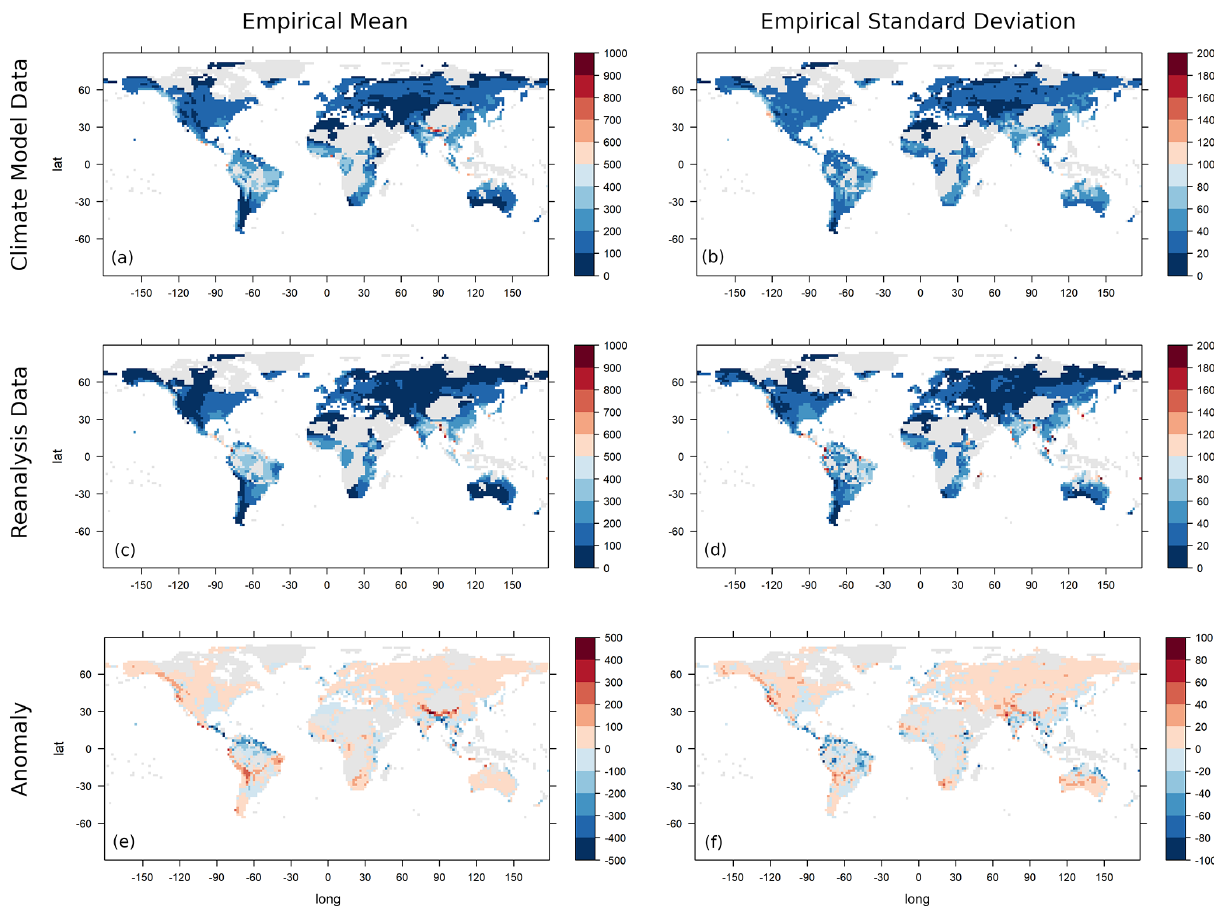
Figure 1. The empirical mean (a, c, e) and empirical standard deviation (b, d, f) of the annual maxima of monthly precipitation of the AWI-ESM model data set (a, b) and the CRU TS4.04 reanalysis data set (c, d) and their difference (model data minus reanalysis data) (e, f) . Values exceeding the scale limits are truncated. Values are given in millimetres per